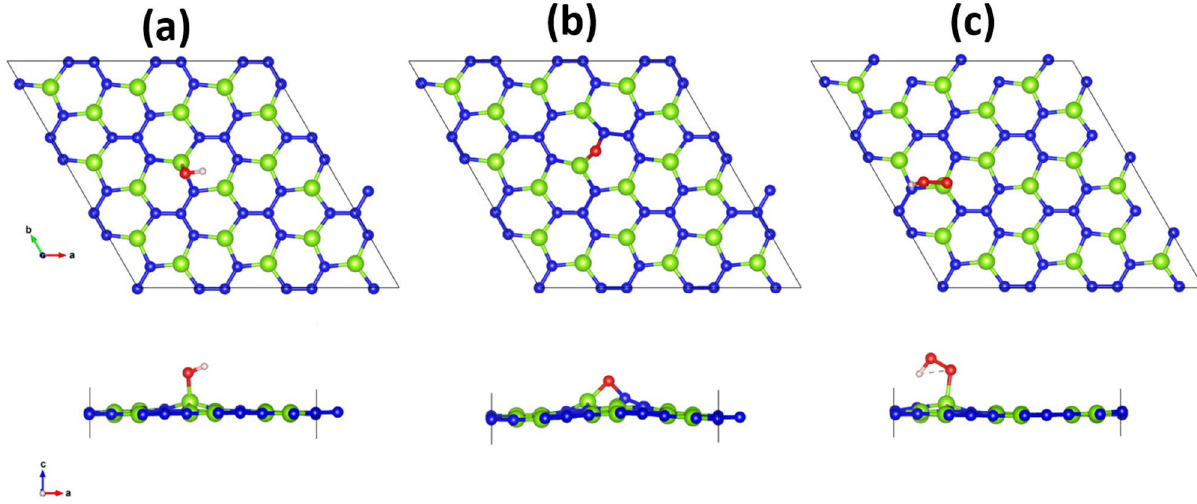
Figure 3. Optimized geometries of possible intermediates in the oxygen evolution reaction; ( a ) *OH, ( b ) *O, and ( c )